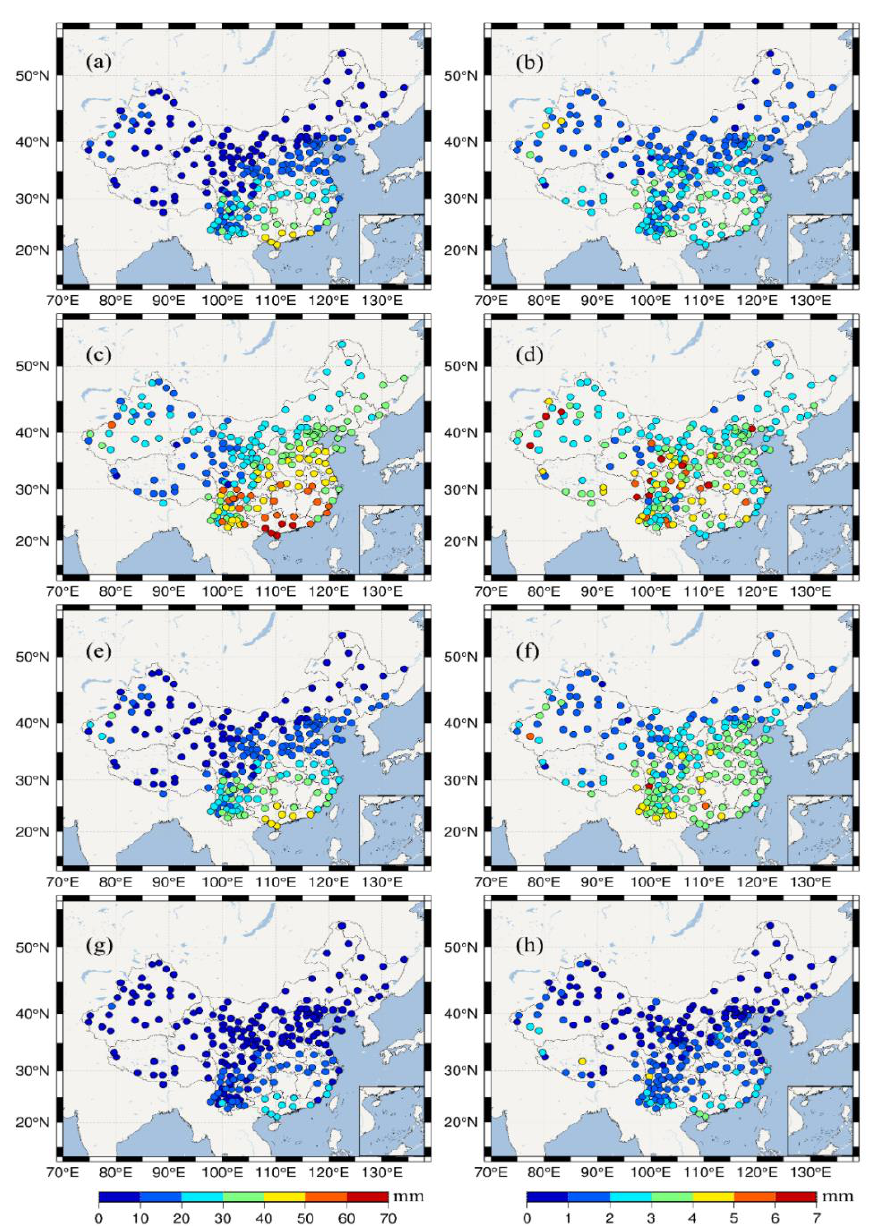
Figure 4. Distribution of the average PWV in different seasons and the RMSE distribution of the ERA5 PWV. ( a , c , e , g ) represent the average PWV in spring, summer, autumn and winter respectively, ( b , d , f , h ) are the corresponding RMSE